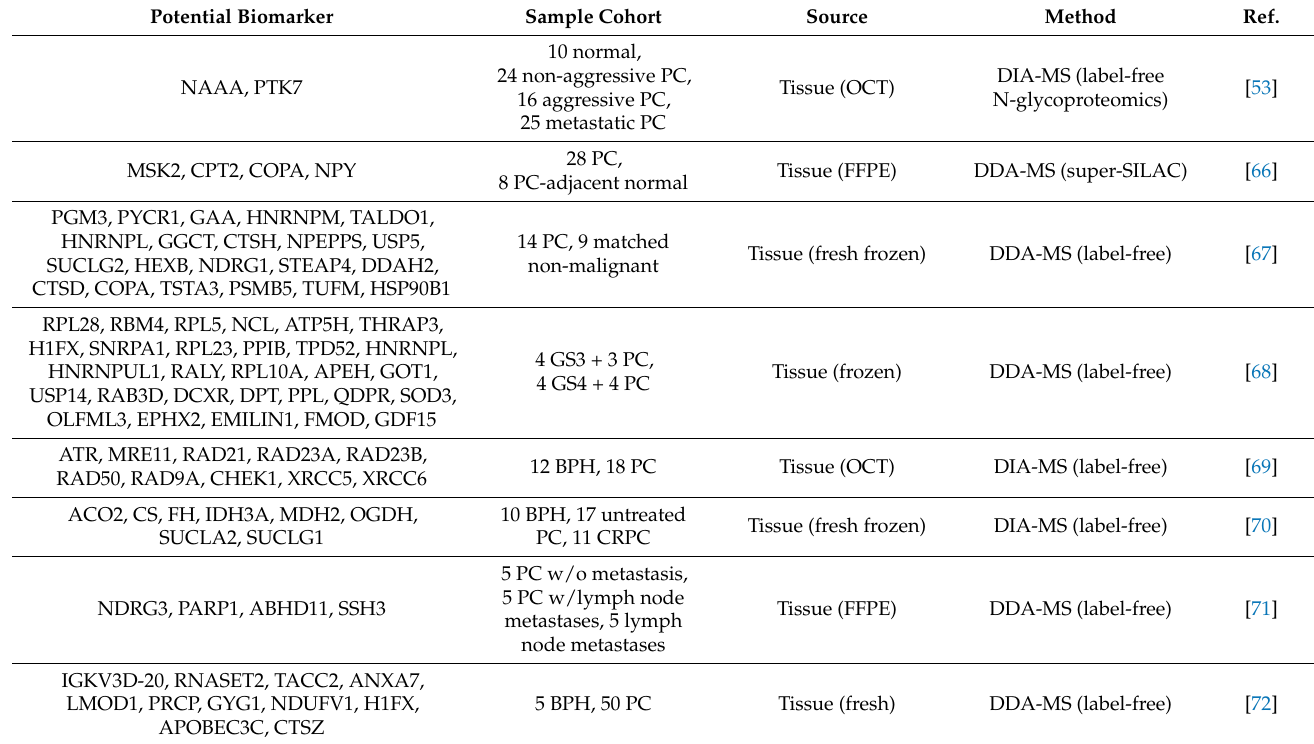
Table 1. List of candidate PC protein markers identified by MS-based discovery proteomics. Potential